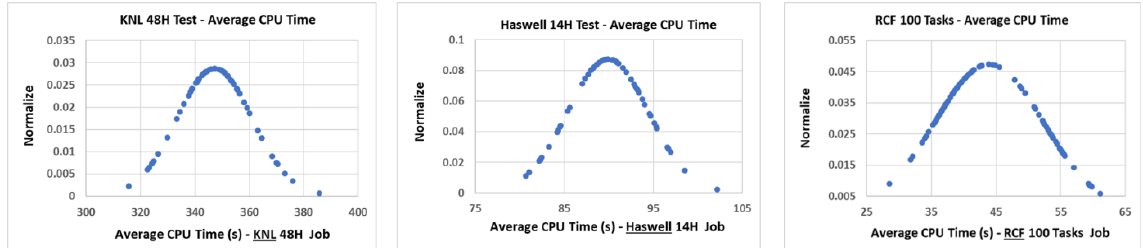
Figure 6. The three plots show the Average CPU time to process events as a gaussian curve consisting of multiple R4S tasks ran on a Cori KNL node, Cori Haswell node, and the RCF. The x-axis is the Average CPU Time shown in